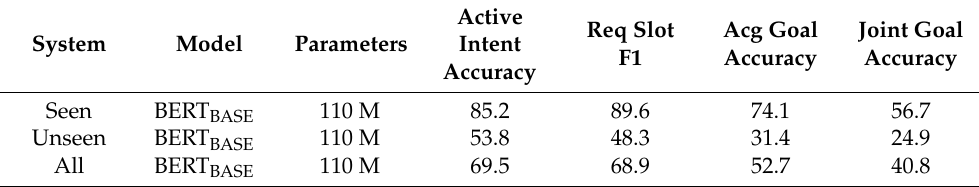
Table 8. SG-CSE Attack state tracker Table 8. SG-CSE A tt ack state tracker performance.